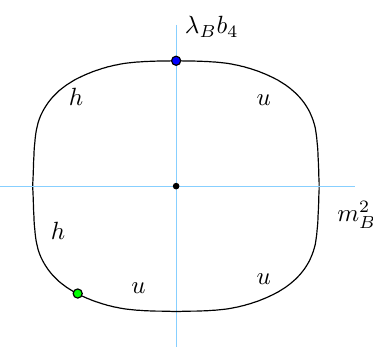
Figure 3 . Phase diagram for the regular boson theory at zero temperature and chemical potential for the stable range φ h < x B < φ u of the marginal parameter x B (refer to (7.14) for the definitions 6 6 of φ h and φ u ). The letter u stands for the unHiggsed phase while the letter h stands for the Higgsed phase. The blue dots are second order transitions while the green dots are first order transitions.